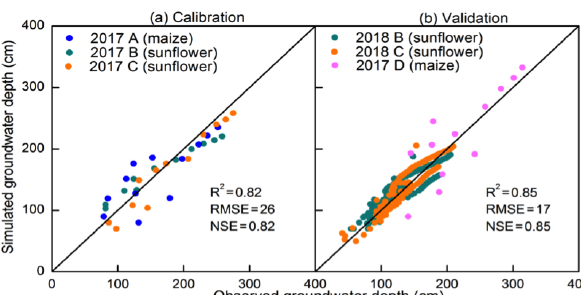
Figure 15. Comparison of predicted and observed groundwater depth: (a) calibration and (b) validation.